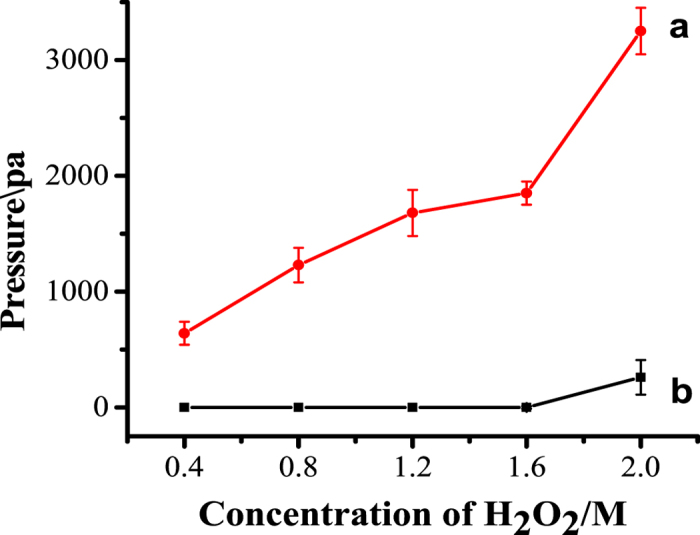
Pressure of different concentration of H2O2 decomposition reaction with 5 μL of Pt/SiO2 (red curve) with the procedure same as the procedure of AFP detection, and the corresponding backgrounds (black curve).